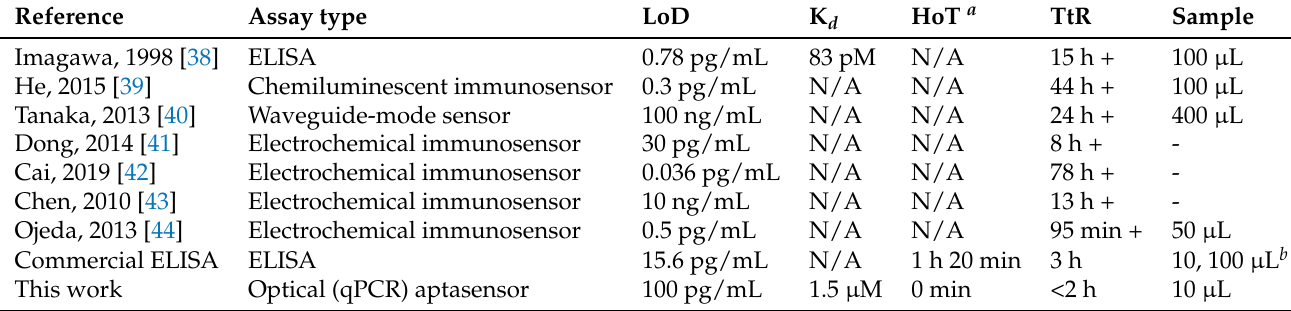
Table 2. Comparison of leptin quantification methods. Reprinted/adapted with permission from Ref. [18]. 2021, American Chemical Society. (LoD: limit of detection; HoT: hands-on time; TtR: time to